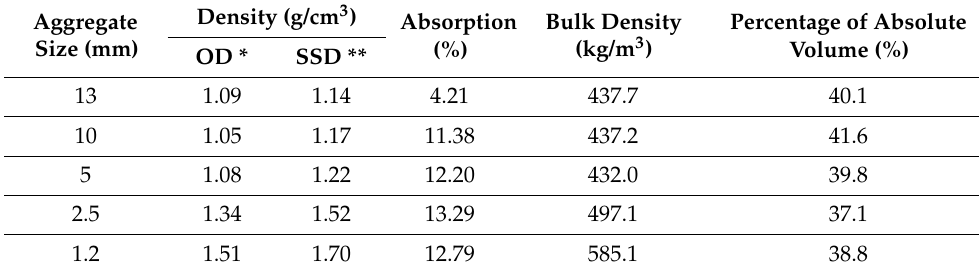
Table 1. Physical properties of dBA according to size.